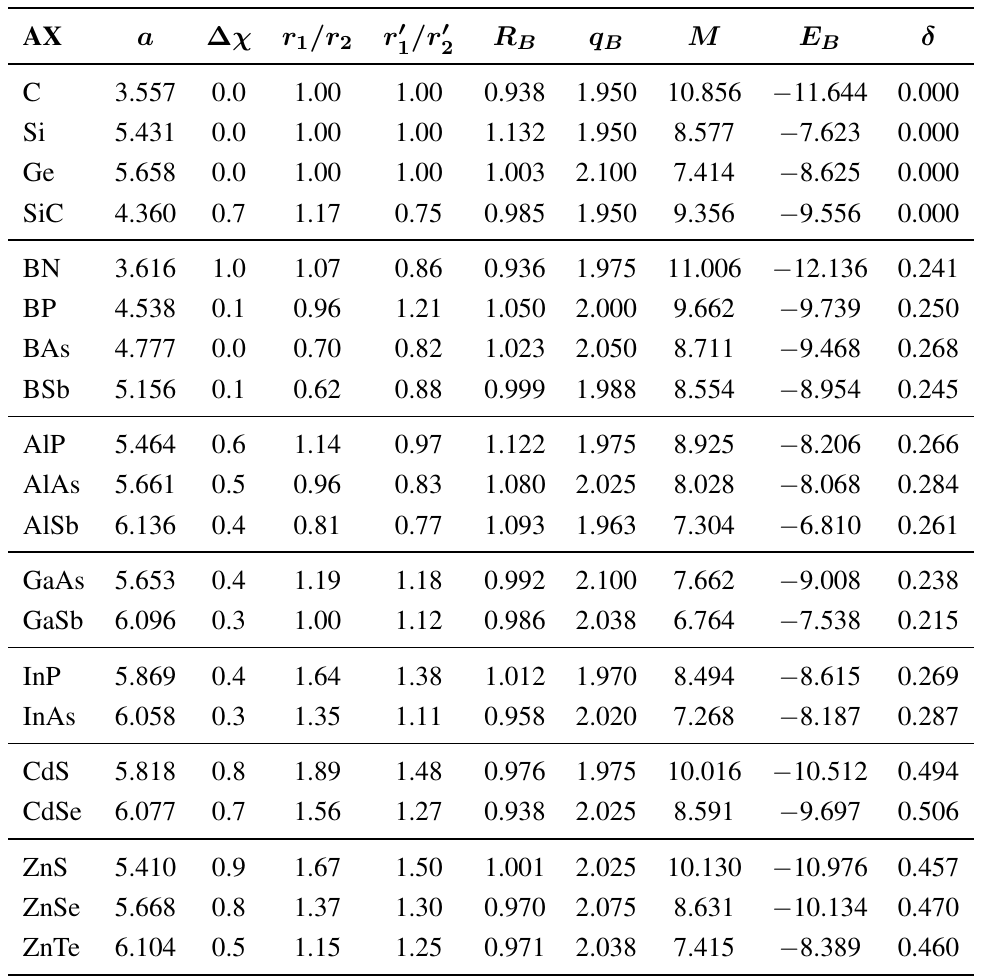
Table 1. Parameters of the non-empirical new bond charge model (NEWBCM), [ q ; R ; r =r ] , for a broad group of diamond-type and zinc-blende-type solids from the B B 1 2 IV, III–V and II–VI groups. r ( r ) stands for the distance between the charge, q , and the 1 2 (cid:0) r = r and ) stands for the part of R belonging to r ( r ), i.e. , r ′ ( r ′ nucleus A ( X ). r ′ 1 A B 1 2 1 2 1 (cid:0) r = r r ′ , where r is the core size of atom A and r is the core size of atom X . M and 2 X A X 2 E stand for the Madelung constant and the bonding energy of the crystal, respectively. The B (cid:0) (cid:31) cell parameter, a , and the electronegativity difference [23], ∆ (cid:31) = (cid:31) , are also shown X A for reference. Lengths are in Å, charges in electrons, energy in